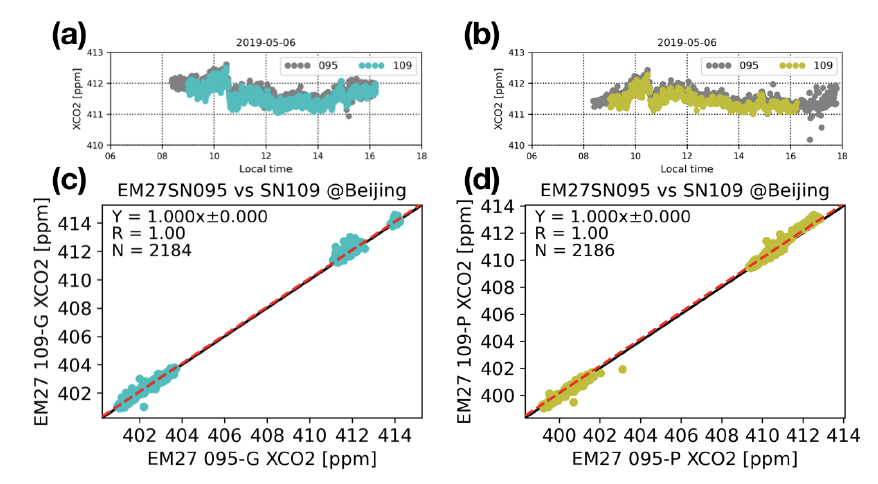
Figure 3. The EM27/SUN SN095 and SN109 XCO 2 measurements retrieved by GGG2020 ( a ) and PRFFAST v1.0 ( b ) on 6 May 2019, together with their correlation plots on all 10 measurement days using GGG2020 ( c ) and PRFFAST v1.0 ( d ). The red dashed line is the linear fitting ( y = ax ). R is the Pearson correlation coefficient. N is the number of co-located data.